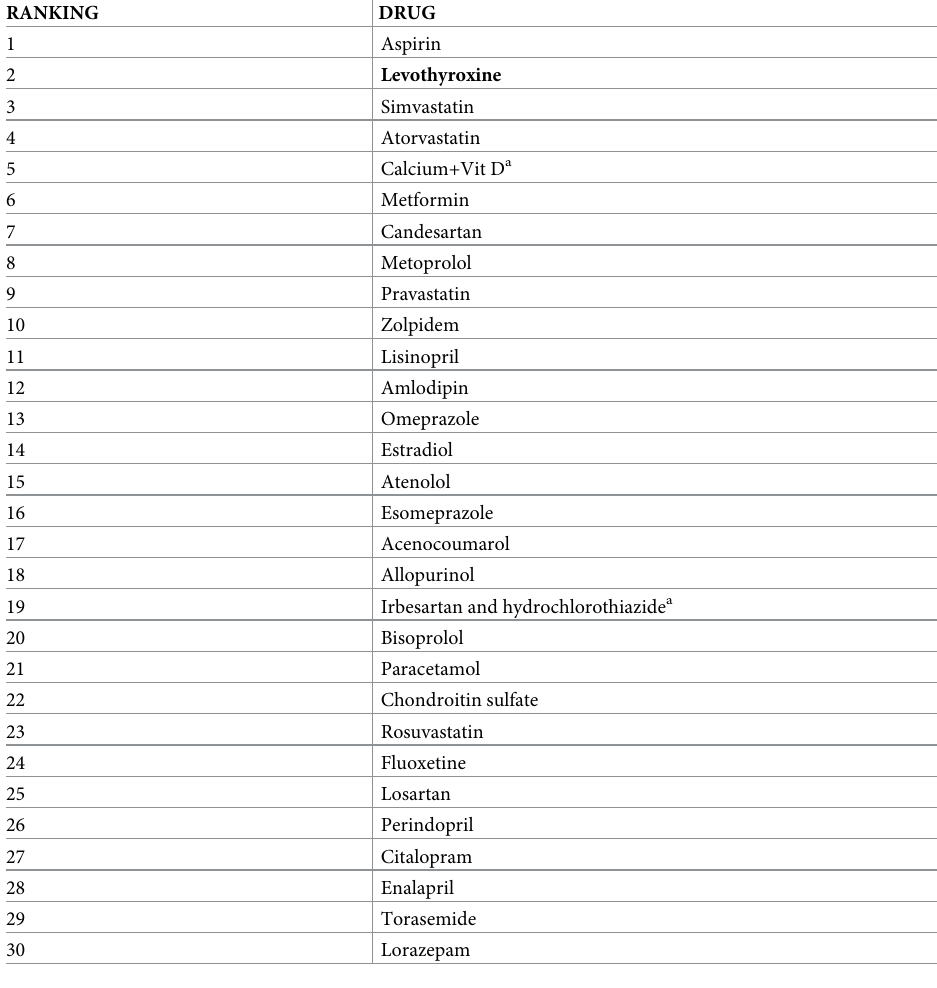
Table 2. Ranking of the most used chronic drugs from the CoLaus|PsyCoLaus cohort.